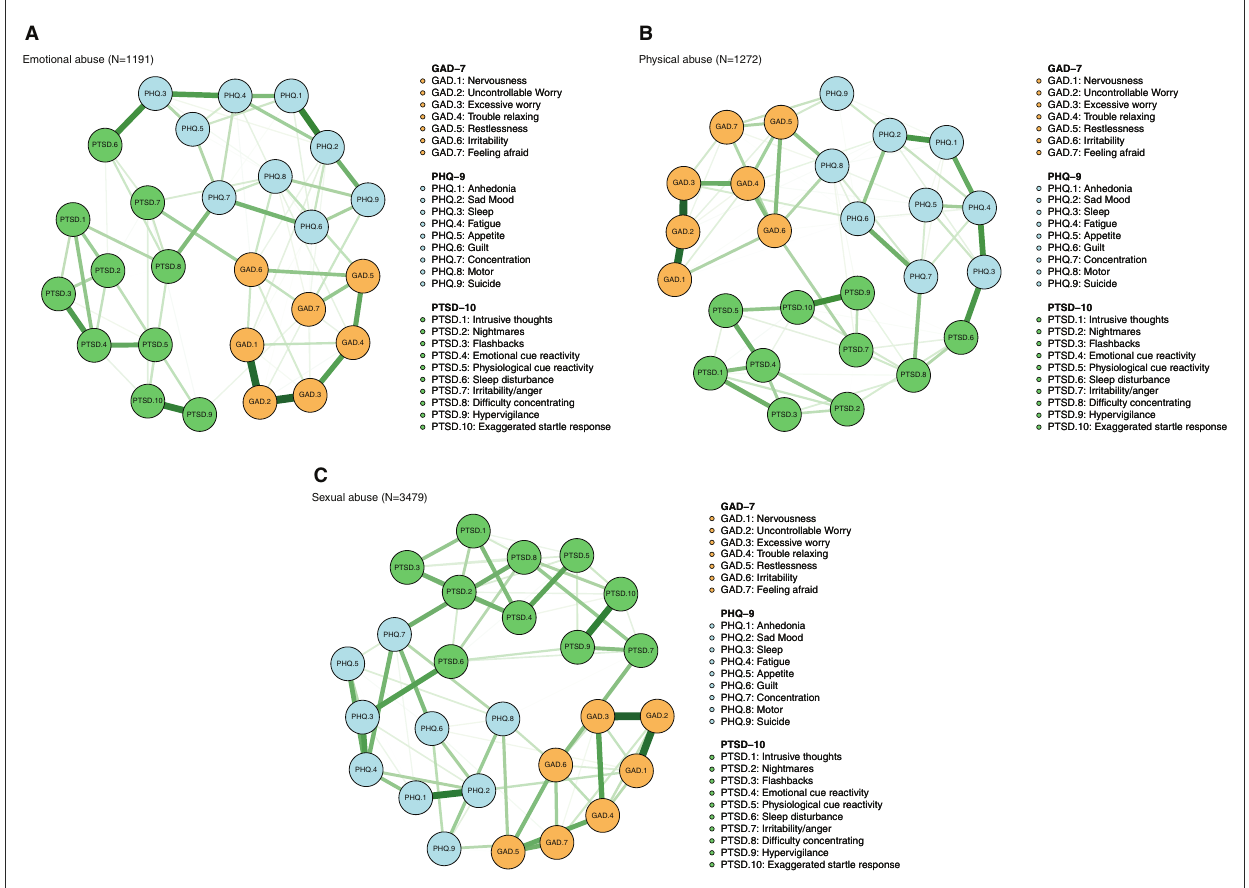
FIGURE1 (A) Symptom network among participants with emotional abuse ( N = 1,191). (B) Symptom network among participants with physical abuse ( N = 1,272). (C) Symptom network among participants with sexual abuse ( N =